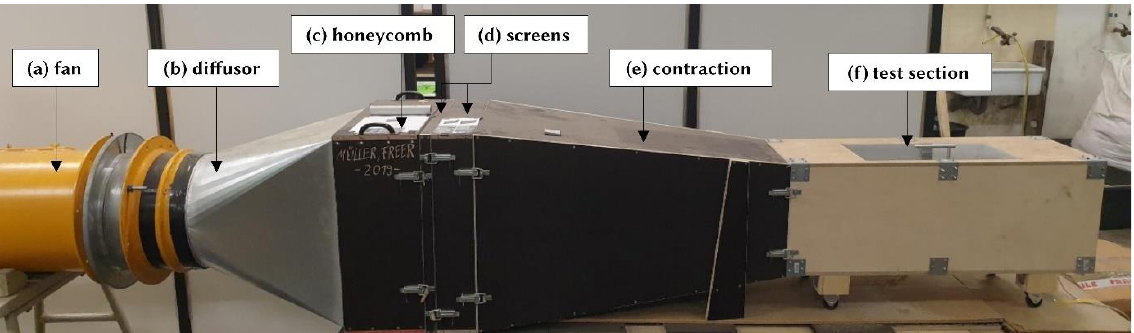
Figure 2. Setup of laboratory experiments. Constructed wind tunnel includes different components to produce a laminar airflow: ( a ) fan, ( b ) diffuser, ( c ) honeycomb slits, ( d ) two screens, ( e ) contraction